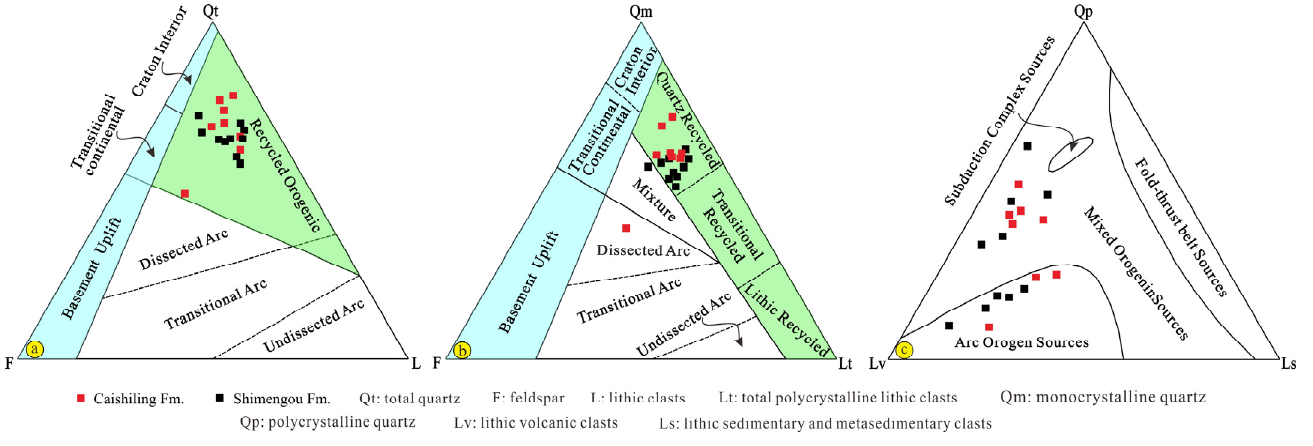
Figure 6. Dickinson diagram of Jurassic sandstones in Yuqia uranium occurrences (modified after Dickinson and Suczek [18]). ( a ) Qt–F–L diagram, ( b ) Qm–F–L diagram, ( c ) Qp–Lv–Ls diagram.